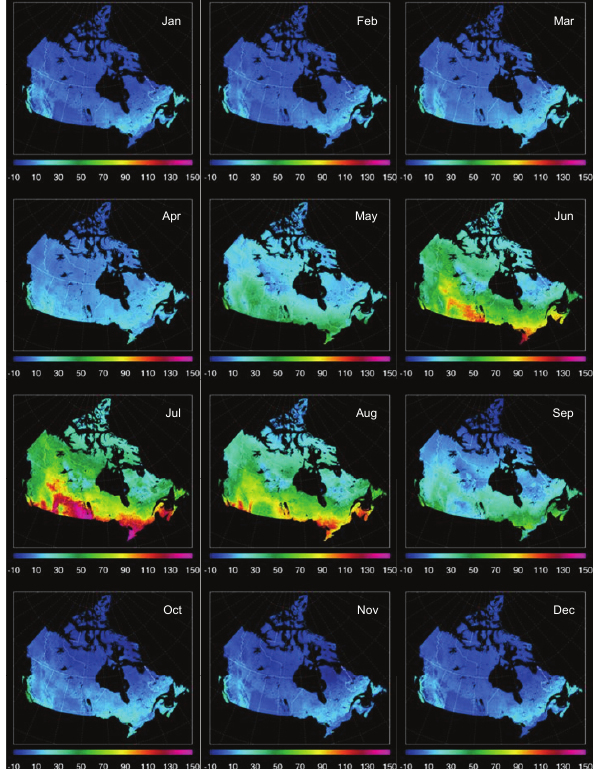
Fig. 12. Spatial distribution of the mean monthly evapotranspiration (mmmonth − 1 ) modeled over Canada’s landmass for